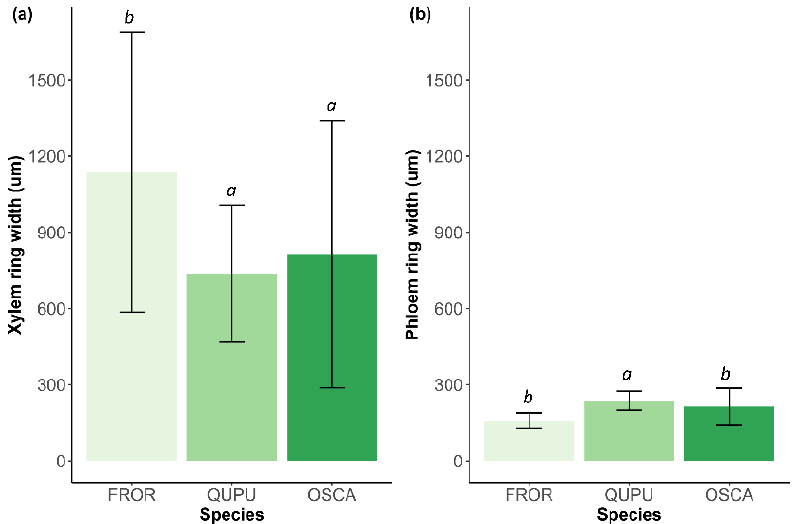
Figure 3. Widths of annual increments in ( a ) xylem and ( b ) phloem in Fraxinus ornus (FROR), Quercus pubescens (QUPU) and Ostrya carpinifolia (OSCA) in Podgorski Kras in 2019. For significance letters see Table 3. Table 3. Xylem and phloem ring widths and anatomical characteristics of initial earlywood vessels (IEVs) and sieve tubes (mean ± standard deviation). Characteristics marked with the same letters are not significantly different (α ≤